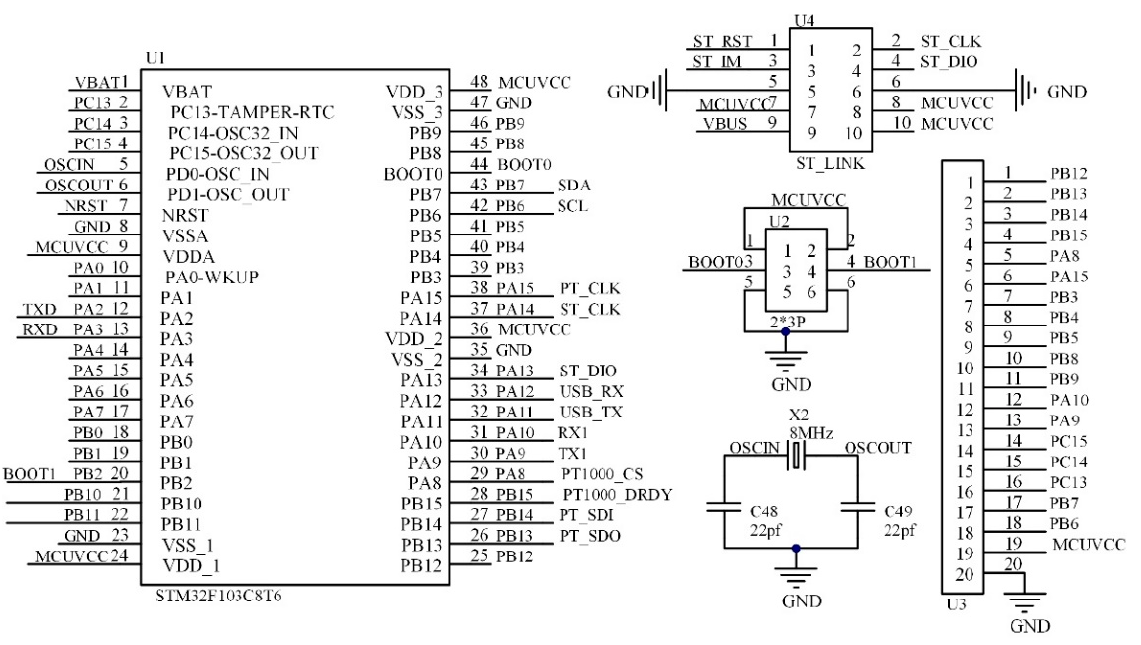
Figure 13. STM32F103C8T6 configuration circuit diagram (2*3P indicates a six-pin row